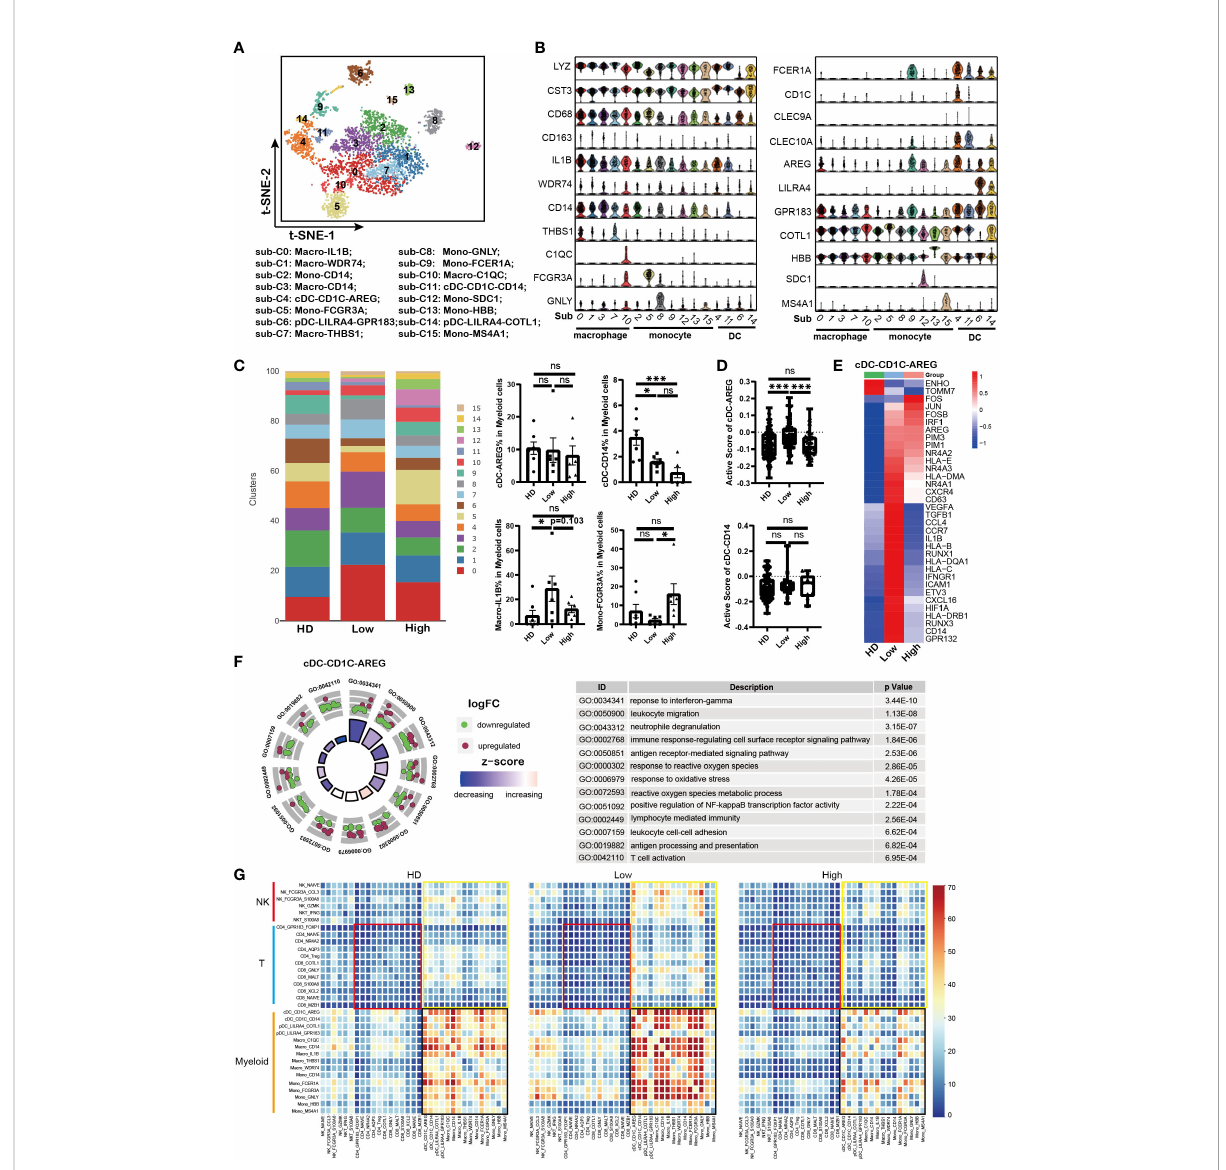
FIGURE 5 Impaired antigen presentation of DCs contributed to T cell dysfunction in MM (A) . t-SNE plot shows the sub-clusters of myeloid cells derived from HD and MM cells. Myelocyte (Cluster 4, 13 and 16 identi fi ed above) were selected for this analysis. Each dot represents a single cell; colors indicate cell clusters with numbered labels. (B) . Violin plots show the expression and distribution of classical cell markers in sub-clusters of myeloid cells from HD and MM patients. The sub-cluster numbers in the graph bottom correspond to the ones in (A) . sub-C0: Macro-IL1B; sub- C1: Macro-WDR74; sub-C2: Mono-CD14; sub-C3: Macro-CD14; sub-C4: cDC-CD1C-AREG; sub-C5: Mono-FCGR3A; sub-C6: pDC-LILRA4- GPR83; sub-C7: Macro-THBS1; sub-C8: Mono-GNLY; sub-C9: Mono-FCER1A; sub-C10: Macro-C1QC; sub-C11: cDC-CD1C-CD14; sub-C12: Mono-SDC1; sub-C13: Mono-HBB; sub-C14: pDC-LILRA4-COTL1; sub-C15: Mono-MS4A1; (C) . Bar charts show the proportion of myeloid sub- clusters among HD and different groups of MM patients. The sub-cluster numbers in right correspond to the ones in (A) . (HD: n=7; Low: n=6; High: n=6). (D) . Bar charts show the active scores of cDC among HD and different groups of MM patients (HD: n=7; Low: n=6; High: n=6). (E) . Heatmap shows the DEGs in cDC-CD1C-AREG among HD and different in fi ltration groups of MM patients. (F) . GO Enrichment of DEGs in cDC- CD1C-AREG between high-in fi ltration and low-in fi ltration groups of MM patients. Each dot in the graphs represents a single gene from DEGs. Upregulated genes are indicated as red dots and downregulated genes are indicated as blue dots. The color bar indicates the z-score of each pathway. (G) . Heatmap shows the interaction strength among immune cells across HD and MM groups. The color showed the interaction strength that was calculated by CellPhoneDB. Black box: the interaction among myeloid cells; Yellow box: the interaction among myeloid cells and T/NK cells; Red box: interaction among T cells. In all instances, p < 0.05 was considered signi fi cant, * p < 0.05 and *** p < 0.001. ns, no signi fi